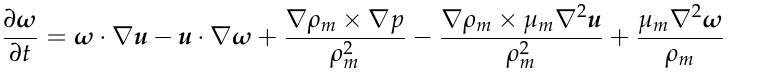
Figure 7. Evolutions of the cavitating vortices and the pressure in a quasiperiod at σ = 2.12. The periodic shedding and unstable flow of vortex cavitation will lead to drastic changes in cavitation morphology, and will significantly enhance the local vorticity distri- bution which will have a significant impact on the evolution of vortex structure. In this paper, the vortex transport equation is introduced to analyze the wake flow field.